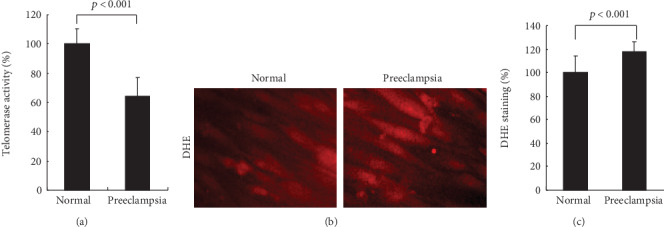
Decreased telomerase activity of hUCB-MSCs from women with preeclampsia. (a) Quantitative analysis of preeclampsia-related alterations of telomerase activity. Mean telomerase activity of hUCB-MSCs was significantly lower in the preeclampsia group (n = 10) than in the normal group (n = 10). Values are the mean ± SD. p < 0.001 by Mann-Whitney U test. (b) Representative photomicrographs showing hUCB-MSCs stained for ROS with DHE, from women with normal pregnancy and preeclampsia. (c) Quantification of DHE intensity of hUCB-MSCs. The DHE staining was determined by densitometry (n = 10 in each group). Relative DHE intensity was significantly higher in the preeclampsia group. Values are the mean ± SD. p < 0.001 by Mann-Whitney U test.